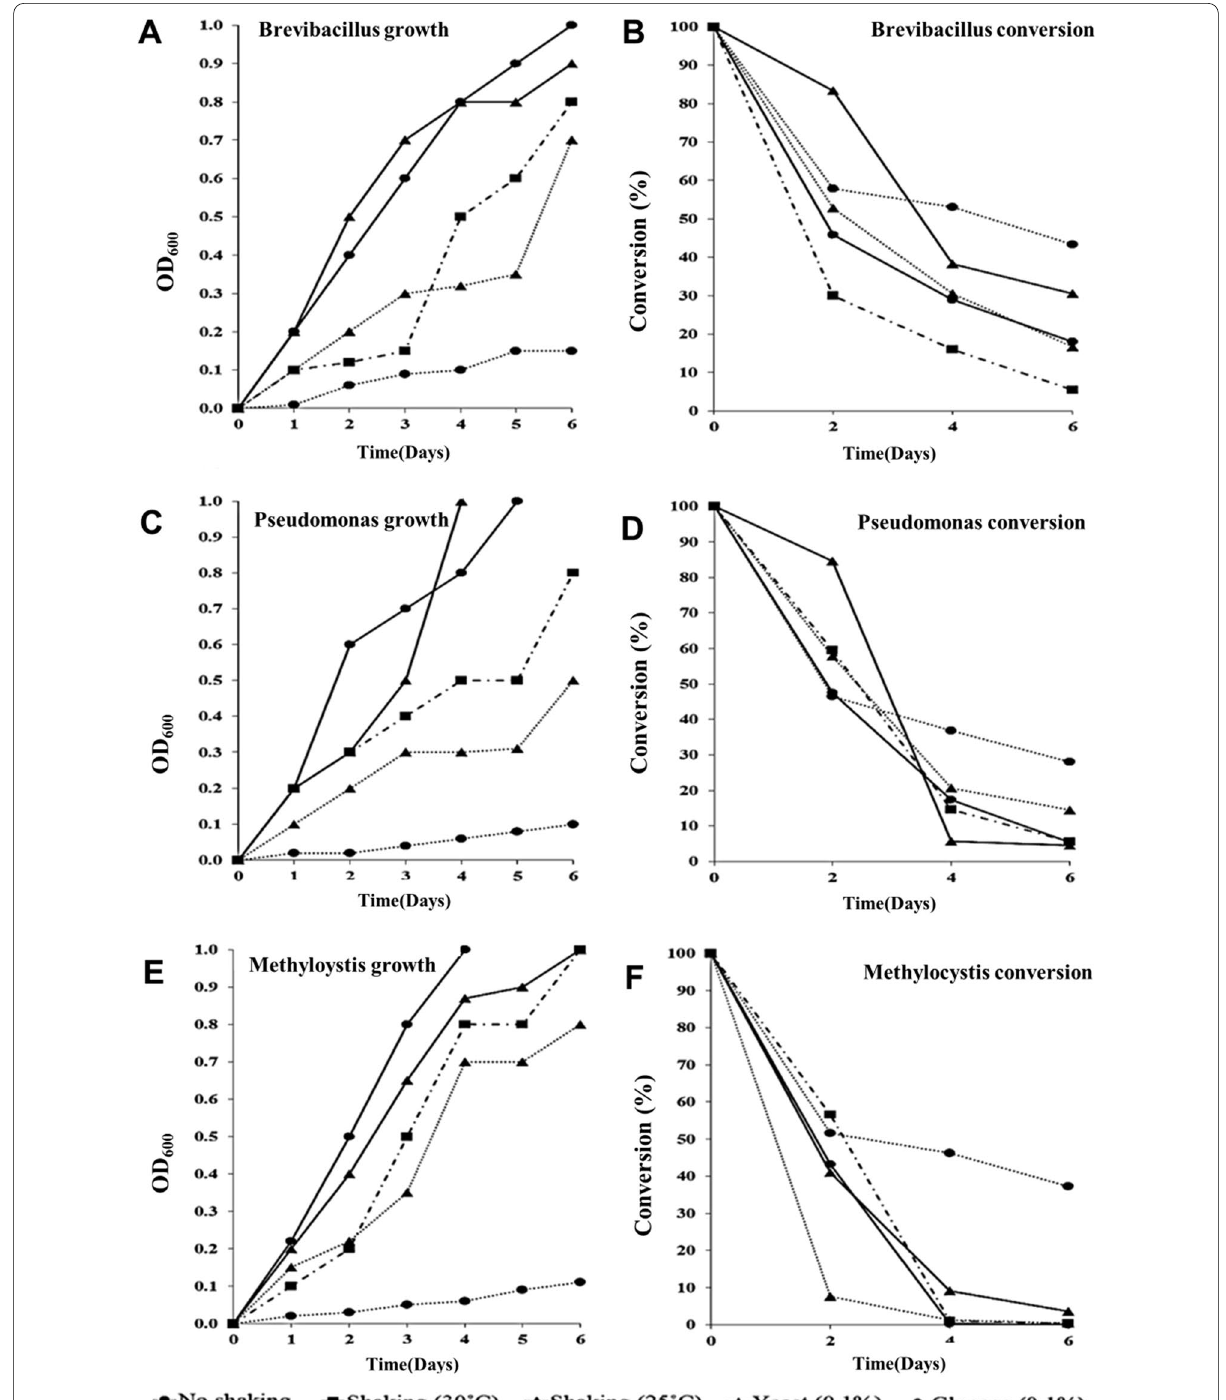
Fig. 2 Enhancement of biomass production and anthracene biodegradation; a , c , e the growth of the three bacterial isolates Brevibacillus sp., Pseudomonas sp., and Methylocystis sp., respectively, on anthracene as a sole carbon source in MSM under five different conditions, i.e., static at 30 °C, shaking at 30 °C, shaking at 25 °C, yeast augmented medium, and glucose augmented medium. The microbial growth was monitored at 600 nm OD. b , d , f the conversion of anthracene at different time points using HPLC for the three isolates Brevibacillus sp., Pseudomonas sp., and Methylocystis sp., respectively, under the same five